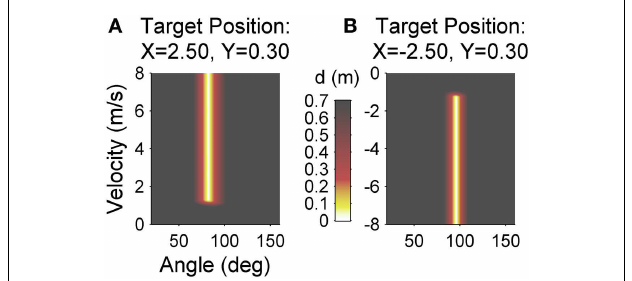
FIGURE 3 | Execution and result space of the intervention task for the left target (A) and the right target (B). For each combination of the execution variables (release angle and velocity) the color codes the result variable, the minimal distance ( d ) of the resulting ball trajectory to the center of the target (error). Red, yellow, and white areas denote target hits ( d <